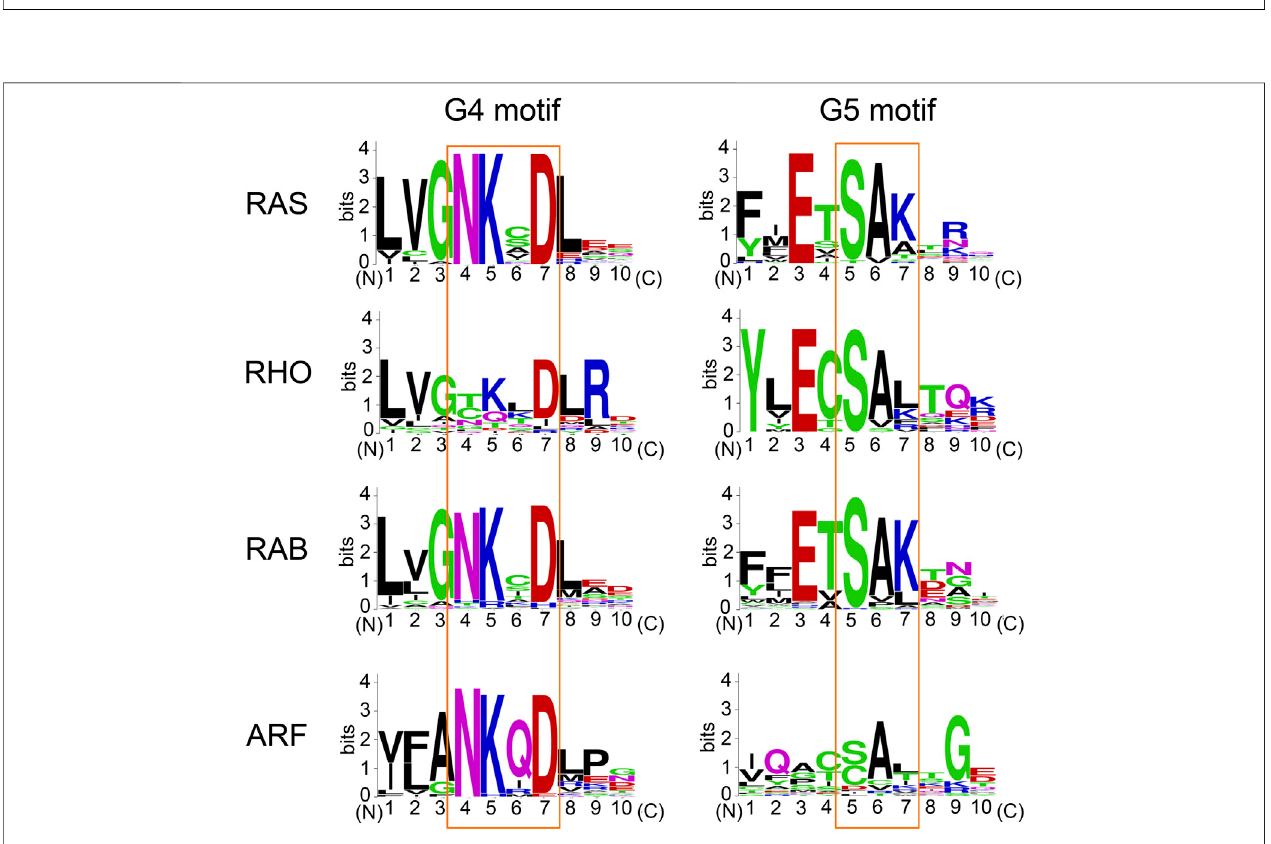
FIGURE 6 | The conservation of amino acids within the G4 and G5 motifs. Sequence alignment performed using Clustal Omega (https://www.ebi.ac.uk/Tools/ msa/clustalo/). The amino acid sequence logo for the G4 and G5 motifs was created using WebLogo (https://weblogo.berkeley.edu/logo.cgi).